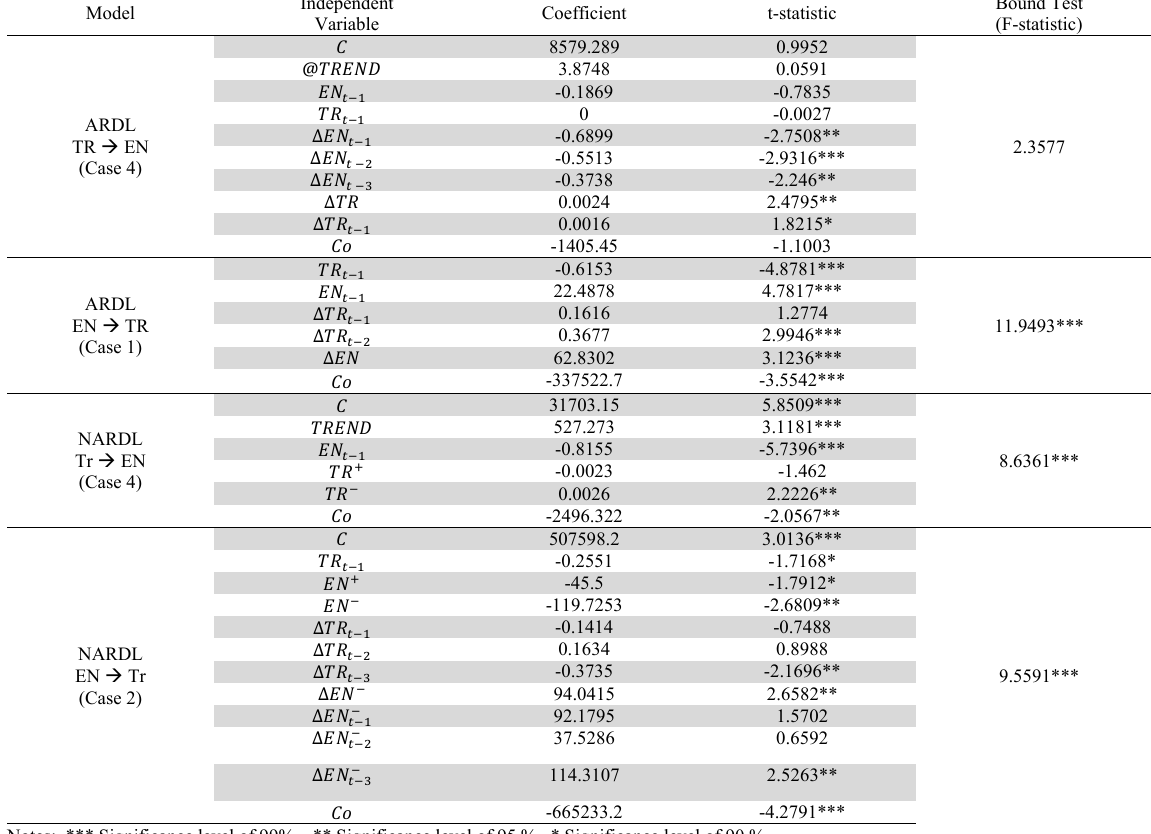
ARDL and NARDL conditional error correction form results